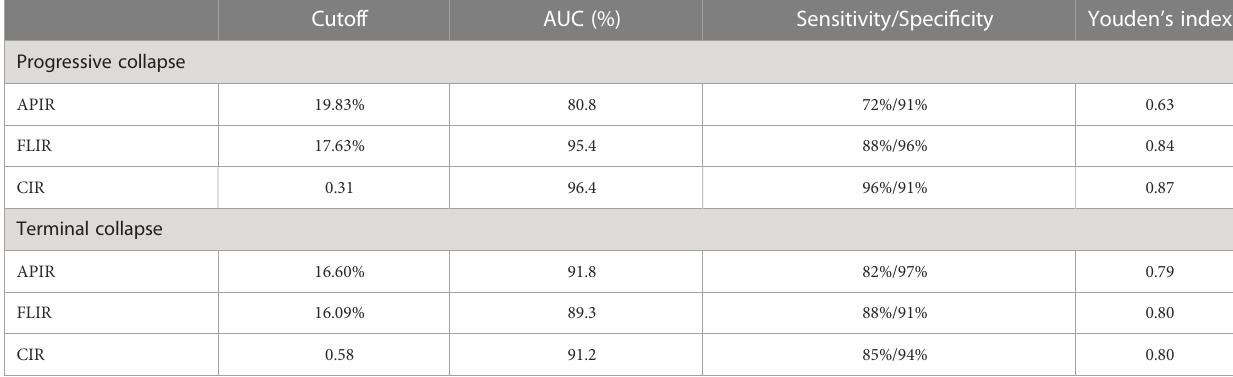
TABLE 5 The ROC Curve Analysis of APIR, FLIR and CIR.